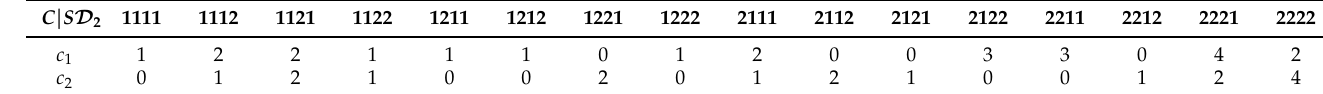
Table 1. Payoff Matrix of G 12